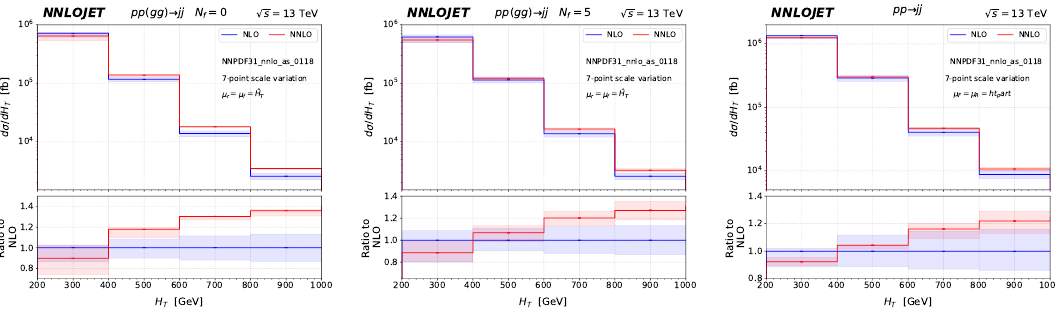
Figure 11 . H T distribution for pp ( gg ) → jj with N f = 0 (left), pp ( gg ) → jj with N f = 5 (centre) and pp → jj (right).